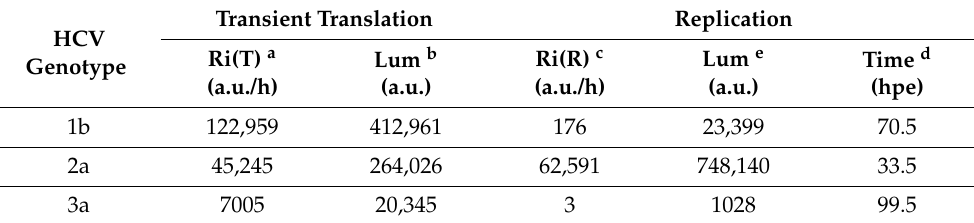
Table 2. Comparison of profiles of transient translation and replication among HCV